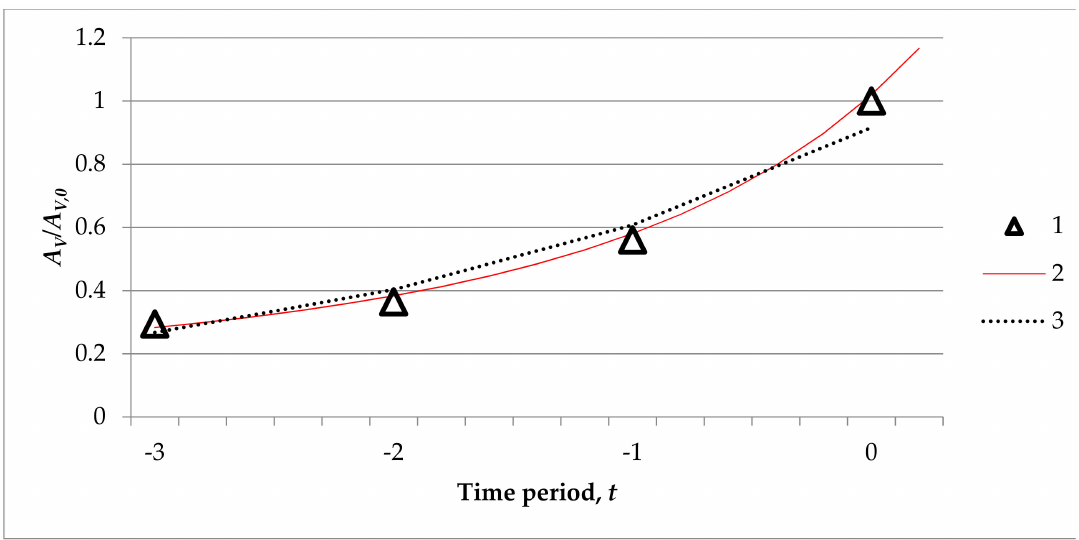
Figure 7. The dependence of the relative density ( A V / A V ,0 ) on the total oak undergrowth in the formation period: 1—data of observations, 2—Gomperz curve, 3—exponent